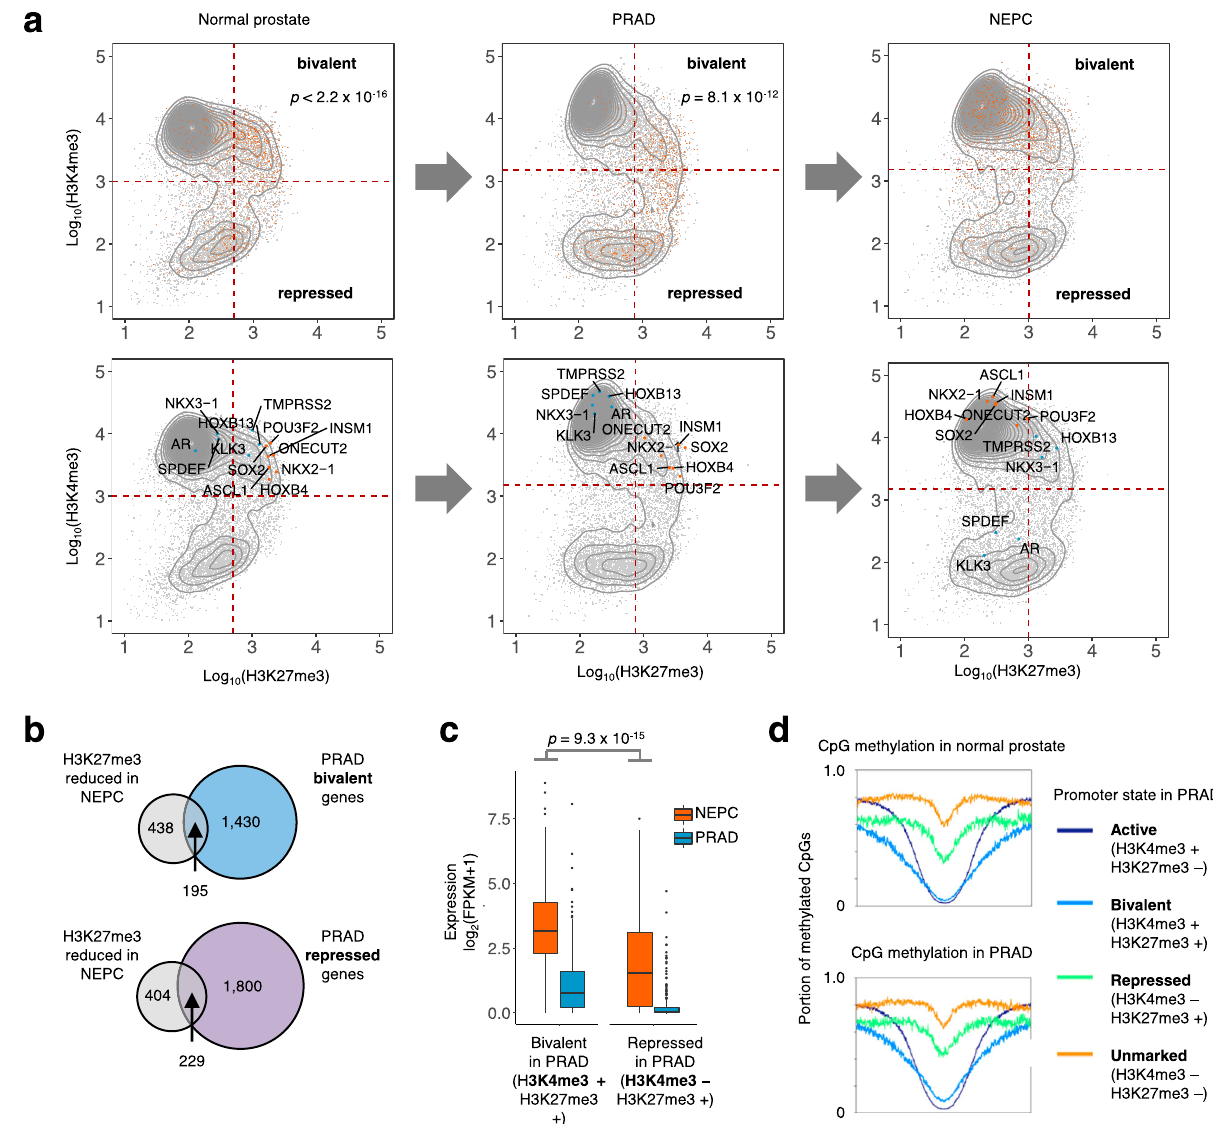
Fig. 6 Encoding of neuroendocrine regulatory programs in the developmental history of prostate cancer. a Average ChIP-seq tag density in normal prostate ( n = 3 samples), PRAD ( n = 5) and NEPC ( n = 5) for H3K4me3 and H3K27me3 within 2 kb of a gene transcriptional start site (TSS). Each dot represents a unique gene TSS. The top row highlights genes with upregulated expression in NEPC compared to PRAD (orange). p -values indicate Pearson ’ s Chi-squared test comparing enrichment of upregulated genes within the “ bivalent ” quadrant compared to the bottom two quadrants. Selected genes are highlighted in the bottom row. b Intersection of genes with bivalent (H3K27me3 + /H3K4me3 + ) or repressed (H3K27me3 + /H3K4me3 − ) promoter annotations in PRAD and genes with reduced promoter H3K27me3 in NEPC vs. PRAD (log 2 fold-change < − 1, FDR-adjusted p -value = 0.01). c Transcript expression levels in NEPC of genes whose promoters lose H3K27me3 in NEPC compared to PRAD. Genes are grouped by bivalent ( n = 1625) or repressed ( n = 2029) promoter annotations in PRAD. Box boundaries correspond to 1st and 3rd quartiles; whiskers extend to a maximum of 1.5x the inter-quartile range. p -value corresponds to two-sided Wilcoxon rank-sum test. d Fraction of CpG methylation in normal prostate tissue and PRAD at TSS ±3 kb for genes in each indicated category. Source data are provided as a Source Data fi